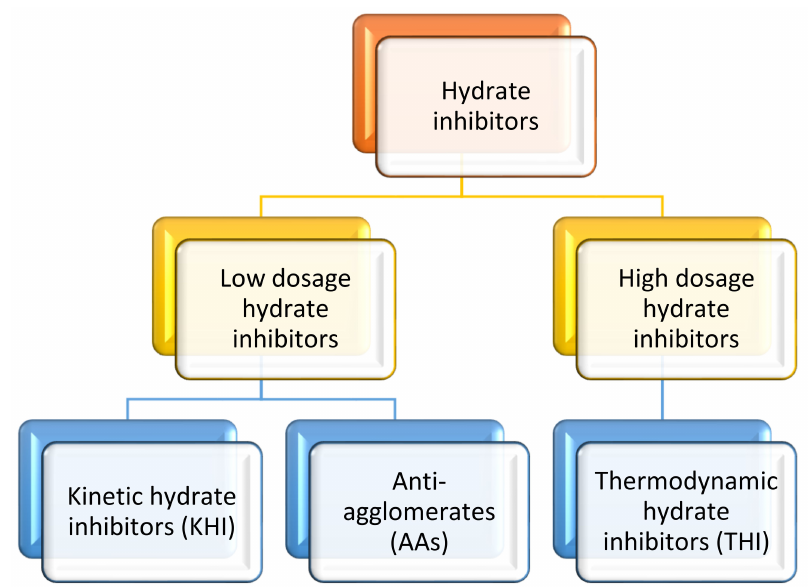
Figure 4. Hydrate inhibitors